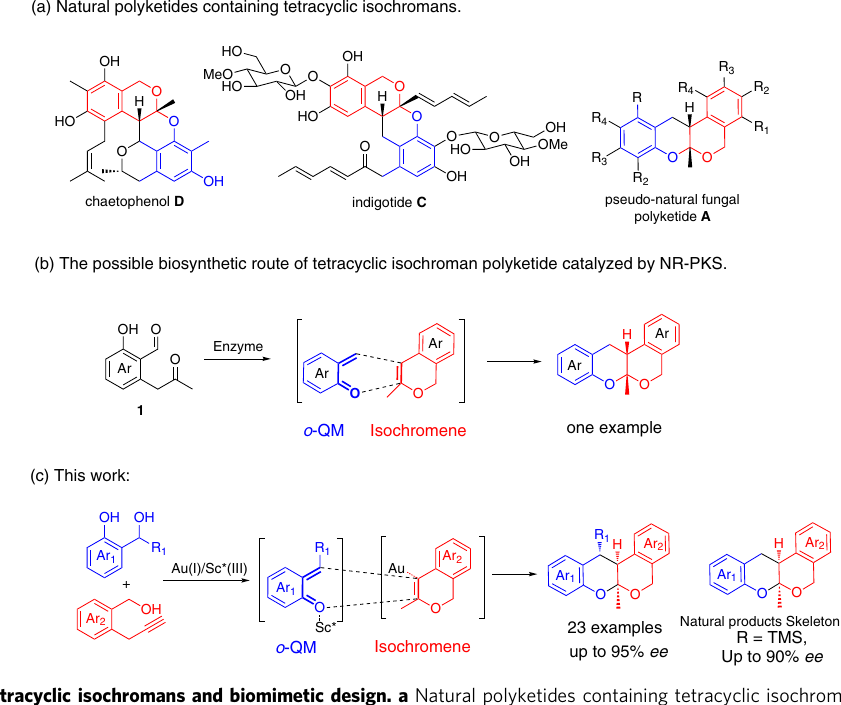
Fig. 1 Background of tetracyclic isochromans and biomimetic design. a Natural polyketides containing tetracyclic isochromans. b The possible biosynthetic route of tetracyclic isochroman polyketide catalyzed by NR-PKS. c The bioinspired Au/Sc*catalyzed HDA